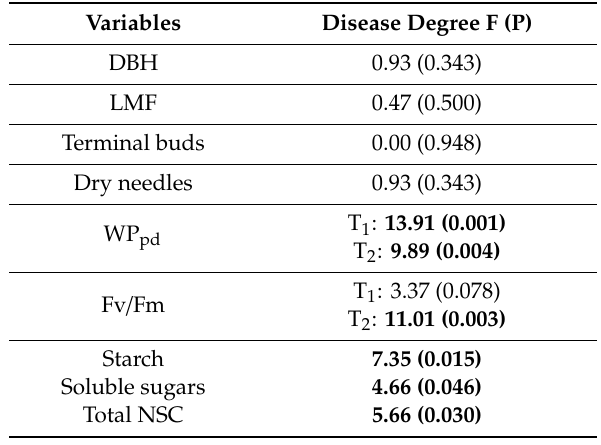
Figure 4. Diameter at breast height (DBH, cm) in each pine stand and disease degree. The striped dark gray bars show the values for the NA-trees; the smooth light gray bars show the values for the NS-trees; the smooth dark gray bars show the values for the S-trees. Data are mean ± SE of n = 6 pines per degree of disease and stand. Table 2. Summary statistics of Linear Model for the measured variables for disease degrees (NA and NS). Significant di ff erences at p < 0.05 are shown in